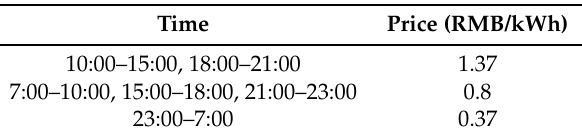
Table 1. Time-of-use price.